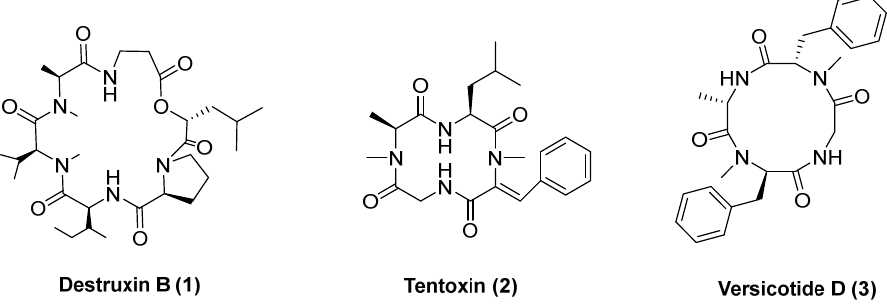
Figure 1. Cyclopeptide natural products with herbicidal activity: destruxin, tentoxin and versicotide D.